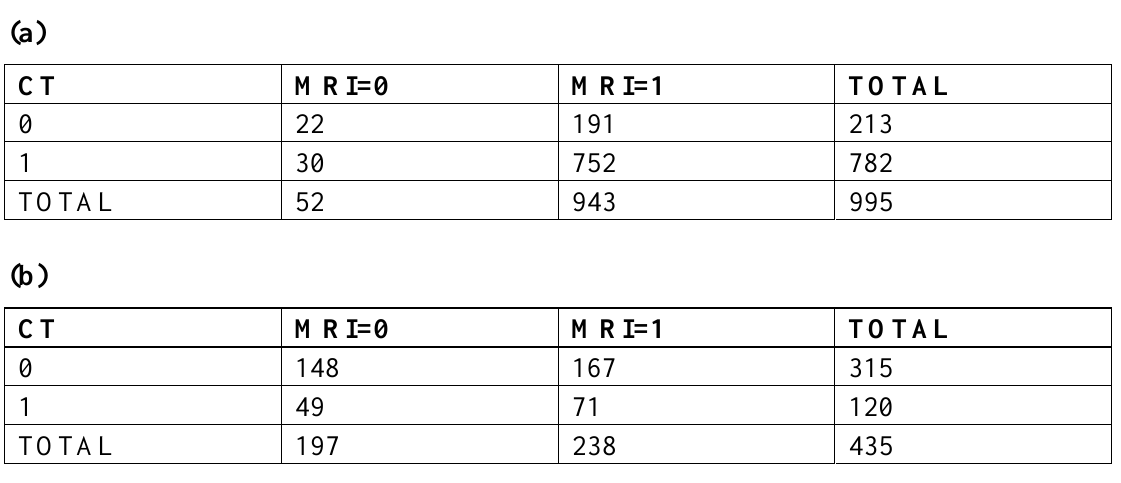
Table 10. (a) CT and MRI study for diseased subjects; ( b) CT and MRI study for non- diseased subjects.